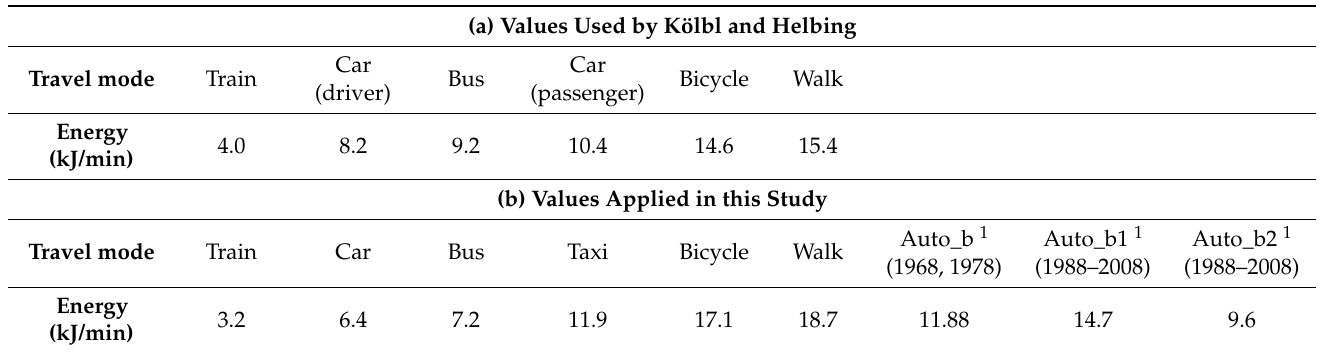
Table 3. Average energy consumption per minute for different travel modes. (a) Values used by Kölbl and Helbing. (b) Values applied in this